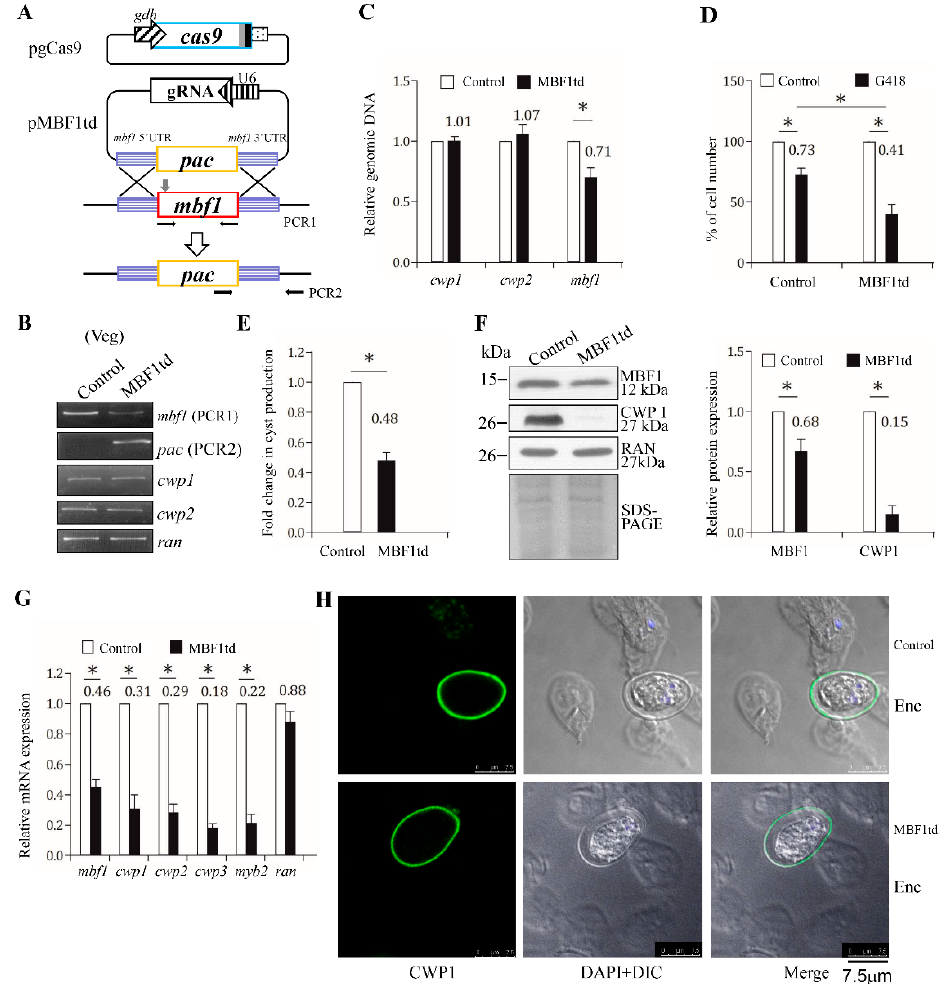
Figure 8. Targeted disruption of the mbf1 gene resulted in decreased expression of the cwp1-3 and myb2 genes during vegetative growth. ( A ) Schematic presentation of the pgCas9 and pMBF1td plasmids. In construct pgCas9, the cas9 gene is flanked by gdh promoter (striated box) and 3 ′ untranslated region of the ran gene (dotted box). The nuclear localization signal (filled gray box) and an HA tag (filled black box) are fused to the C terminus. In construct pMBF1td, a single gRNA is under the control of the Giardia U6 promoter. The single gRNA, which is located upstream three nucleotides of protospacer-adjacent motif (NGG sequence), includes a guide sequence targeting 20-nucleotide of the mbf1 gene (nt 126–145). pMBF1td also has the HR template cassette composed of the pac selectable marker and the 5 ′ and 3 ′ flanking region of the mbf1 gene as homologous arms. The Cas9/gRNA cutting site in the genomic mbf1 gene is indicated by a gray arrow. Replacement of the genomic mbf1 gene with the pac gene will occur by HR, after introducing a double-stranded DNA break in the mbf1 gene. After transfection of the pgCas9 and pMBF1td constructs into G. lamblia WB trophozoites, the MBF1td stable transfectants were established under puromycin selection. The control cell line is trophozoites transfected with double amounts of 5 ′ Δ 5N-Pac plasmid (Figure 2C) and selected with puromycin. PCR1/2 were used for identification of clones with targeted disruption. ( B ) PCR confirmed partial replacement of the mbf1 gene with the pac gene in the MBF1td cell line. Genomic DNA was isolated from the MBF1td and control cell lines cultured in growth medium with puromycin (vegetative growth, Veg) and subjected to PCR using primers specific for mbf1 (PCR1 in panel A), pac (PCR2 in panel A), cwp1, cwp2, and ran genes, respectively. Products from the cwp1, cwp2, and ran genes are internal controls. ( C ) real-time PCR confirmed partial disruption of the mbf1 gene in the MBF1td cell line. Real-time PCR was performed using primers specific for mbf1, cwp1, cwp2, and ran genes, respectively. The mbf1, cwp1, and cwp2 DNA levels were normalized to the ran DNA level. The ratio of DNA levels in MBF1td cell line to levels in control cell line is shown and expressed as the means ± 95% confidence inter- vals of at least three separate experiments. *, p < 0.05. ( D ) G418 sensitivity increased by targeted